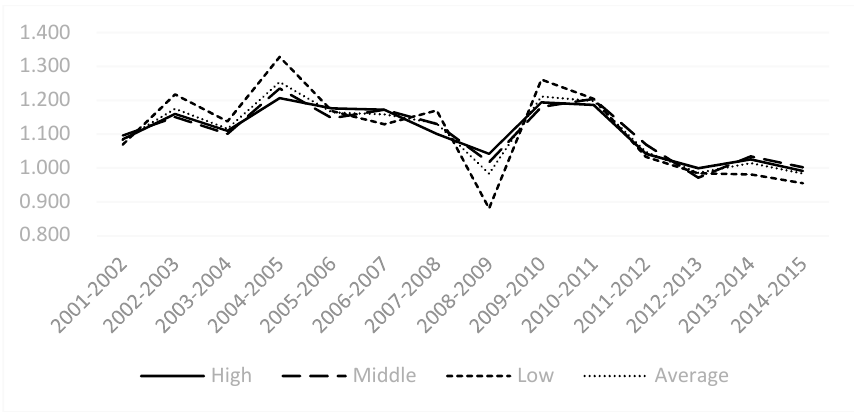
Figure 5. Frontier effects of China’s heavy pollution industry from 2001 to 2015.